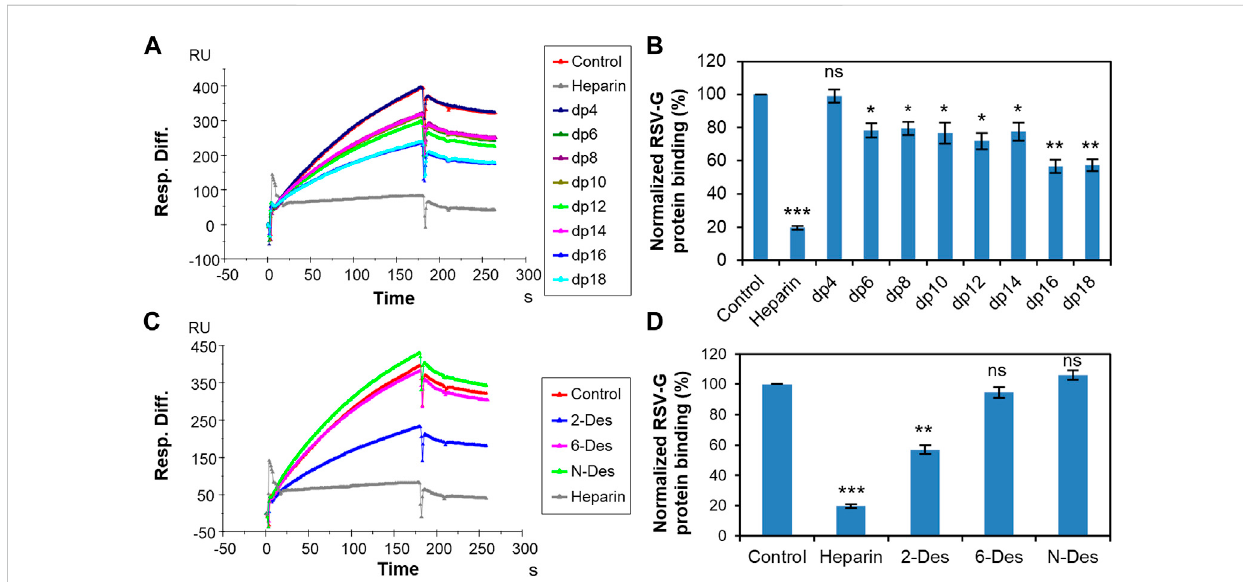
FIGURE 2 RSV-Gprotein – heparininteractioninhibitedbyheparinoligosaccharides ordesulfatedheparinsusingsolutioncompetition. (A) SPRsensorgramsof RSV-G protein – heparin interaction competing with different heparin oligosaccharides. Concentration of RSV-G protein is 250 nM mixed with 1,000 nM of different heparin oligosaccharides. (B) Bar graphs (based on triplicate experiments with standard deviation) of normalized RSV-G protein binding to surface-immobilized heparin by competing with different heparin oligosaccharides. (C) SPR sensorgrams of RSV-G protein – heparin interaction competing with different desulfated heparins. Concentration of RSV-G protein is 250 nM mixed with 1,000 nM of different desulfated heparins. (D) Bar graphs(basedontriplicateexperimentswithstandarddeviation)ofnormalizedRSV-Gproteinbindingtosurface-immobilizedheparinbycompetingwith different desulfated heparins. Statistical analysis was performed using unpaired two-tailed t -test (ns: p > 0.05 compared to the control, *: p ≤ 0.05 compared to the control, **: p ≤ 0.01 compared to the control, ***: p ≤ 0.001 compared to the